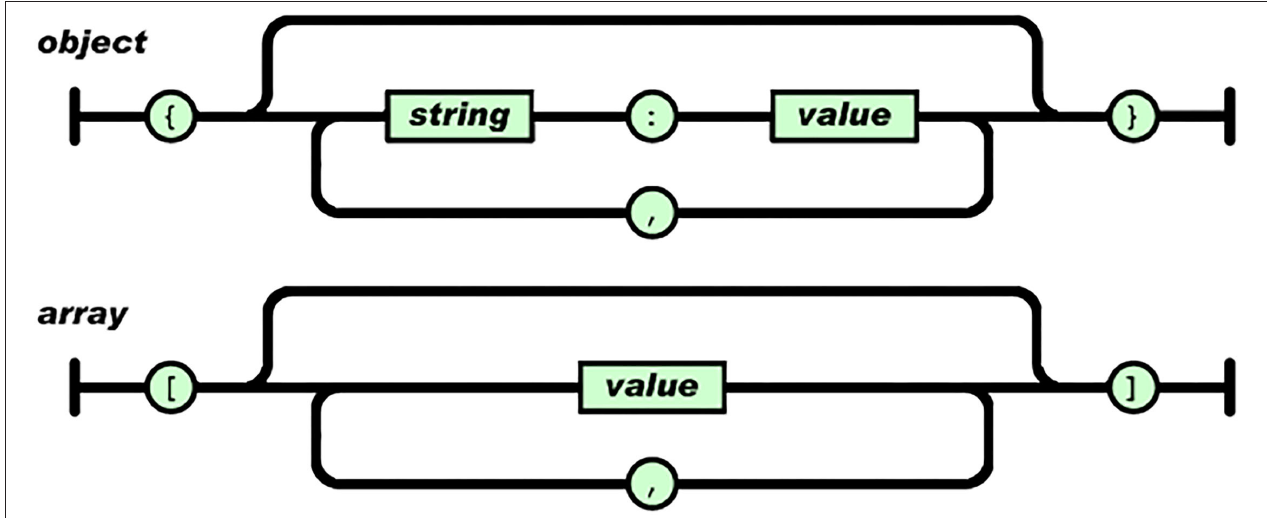
FIGURE 1 | Structure of